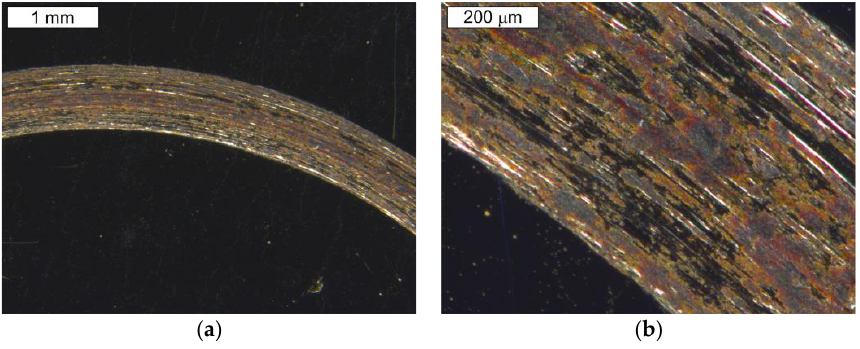
Figure 11. Photographs of: ( a ) a stereoscopic image of the friction face for steel NC11LV and ( b ) a magnified fragment of the area from Figure 11a. Stereoscopic